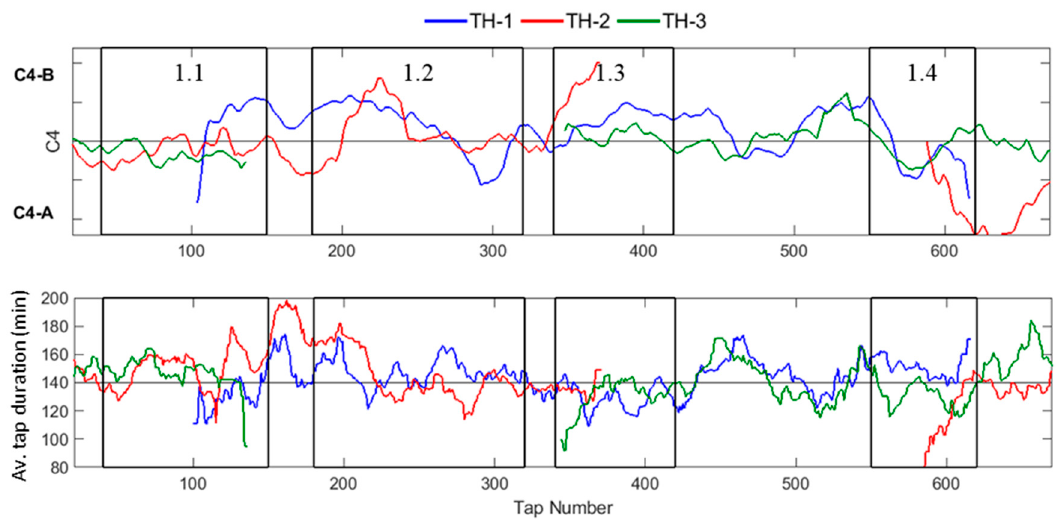
Figure 8. Fourth principal component (C4, top ) and average tap duration ( bottom ) corresponding to the four periods of Data set 1. Blue line (TH-1), red line (TH-2), and green line (TH-3).